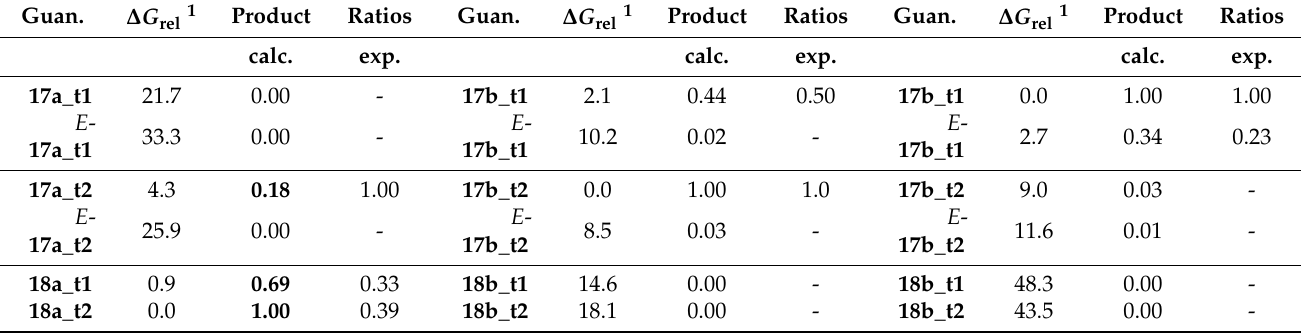
Table 2. The relative Gibbs energies ( ∆ G rel ) of the possible isomeric reaction products calculated using the M08-HX approach 1